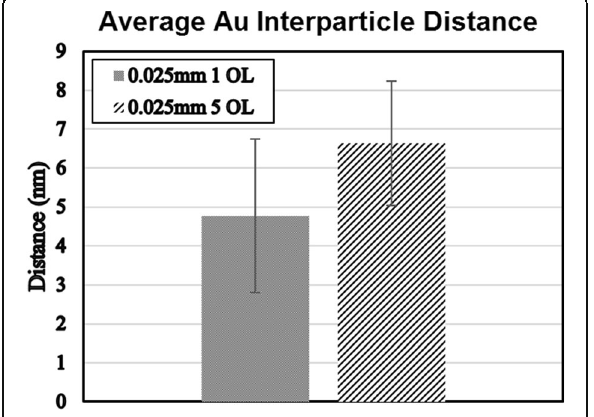
Fig. 14 Experimental interparticle distances of gold sputtered silicon samples for 1 OL and 5